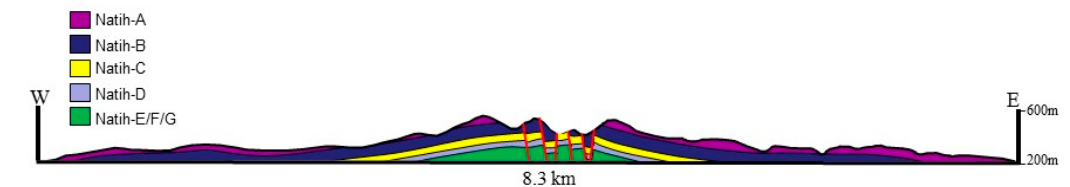
Figure 7. Surface cross sections through Jebel Qusaibah. The locations of the cross sections are shown in Figure